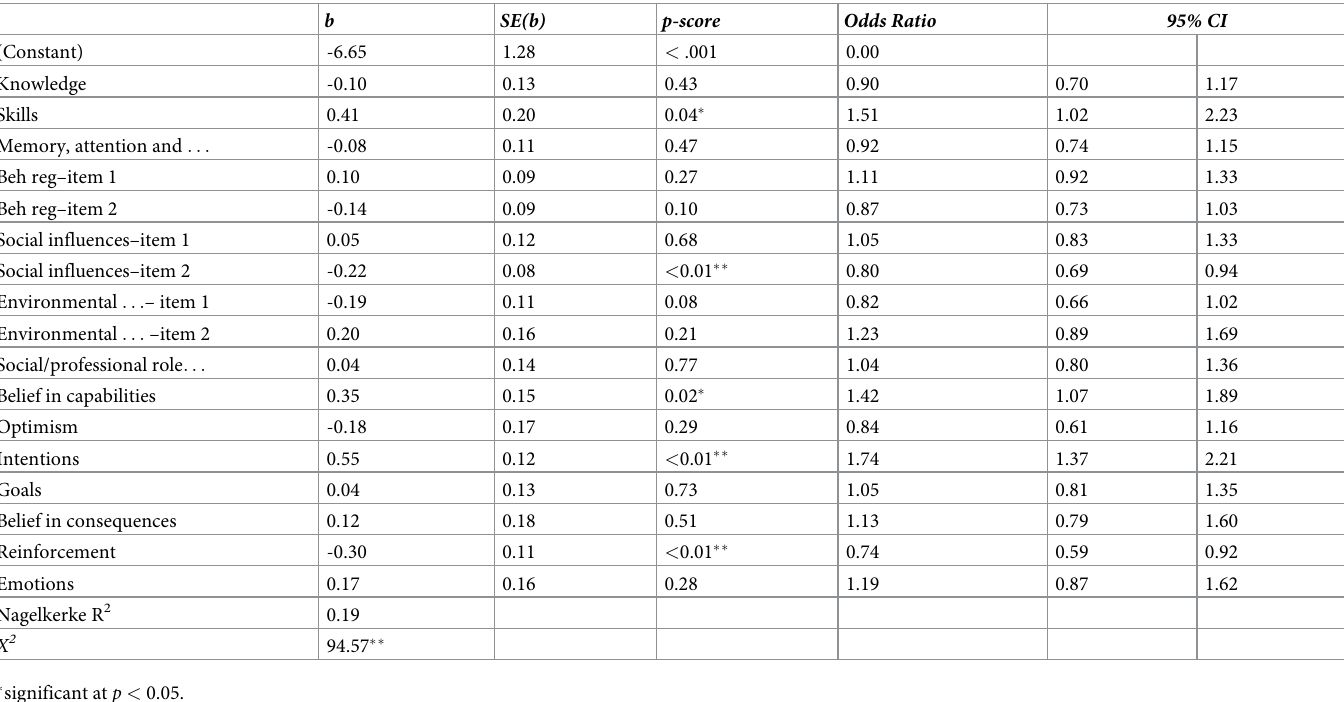
Table 6. Logistical regression predicting Actual Behavior from domain composite scores: Diagnostic 2 survey about actual behavior.